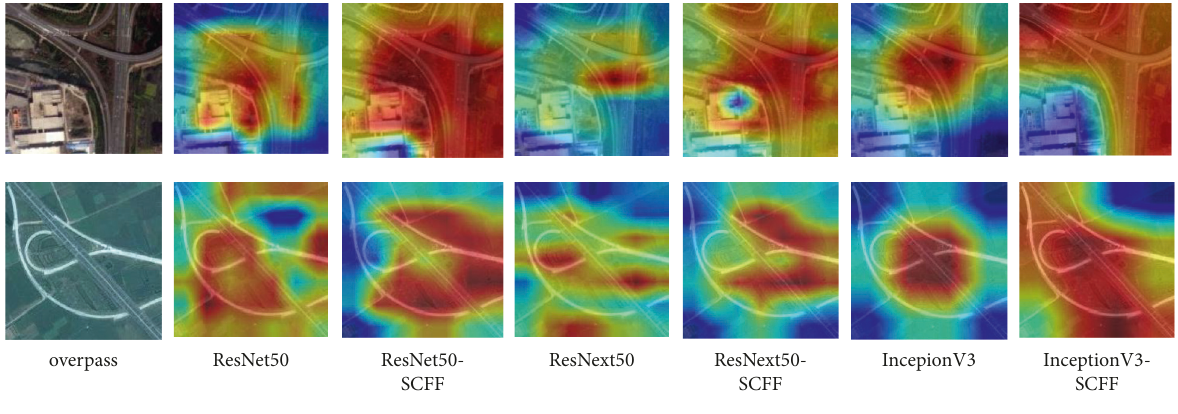
Figure 9: Heatmap